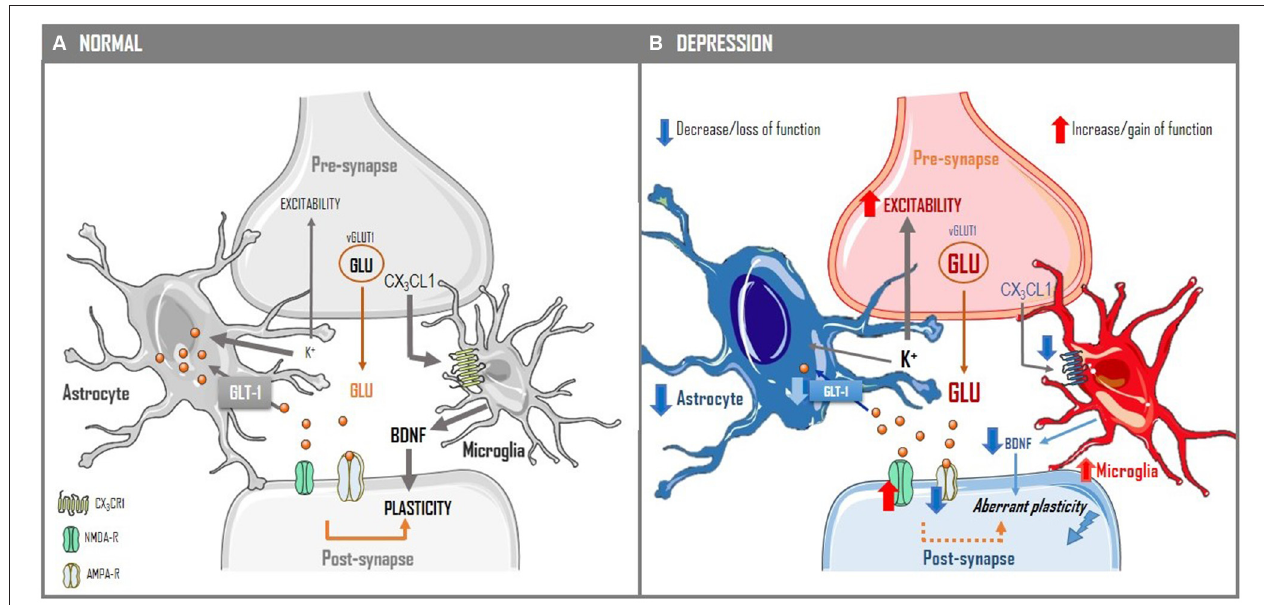
FIGURE 1 | Modifications of the quad-partite synapse in depression. The processing of information in synapses is not only defined by neurons, but also by glia cells, namely by astrocytes, which enwrap synapses, and microglia, which dynamically interact with synapses in an activity-dependent manner (A) . Thus, amongst other roles, astrocytes regulate both K + and the basal levels of glutamate, defining the basal excitability of neurons; also the extracellular levels of glutamate contribute to define the density of NMDA and AMPA receptors in the plasma membrane of the post-synaptic compartment, which trigger and sustain alterations of synaptic plasticity, respectively. The excitability of neurons, their set-up of plasma membrane glutamate receptors, namely of NMDA receptors, and the neurotrophins support provided by glial cells are critical to allow the implementation of adequate synaptic plasticity traits, i.e., an appropriate encoding of both long-term potentiation (LTP) and depression (LTD) according to specific patterns of incoming information. In depression (B) there is a modification of information processing in excitatory synapses in frontolimbic area: there is modification of astrocytes, typified by hypertrophic cell bodies and decreased complexity and activity of phylopodia, resulting in an hypofunction of astrocytes and a decreased ability to buffer K + and to clear extracellular glutamate; this leads to increased excitability, corresponding to greater noise in the circuit, and to an imbalance of NMDA and AMPA receptors, with an increased availability of NMDA receptors in dendrites. Additionally, there is a decreased signaling through the master chemokine CX3CL1 in microglia, which is associated (through mechanisms still undefined) to a shift of microglia towards a more pro-inflammatory profile associated with decreased microglia-derived BDNF release. These alterations of the quad-partite synapse, typified by the altered inter-relations between glial cells and neurons, are associated with an aberrant plasticity, typified by a shift in the stimuli triggering LTD and LTP, which translates into inadequate encoding of information in frontocortical circuits.